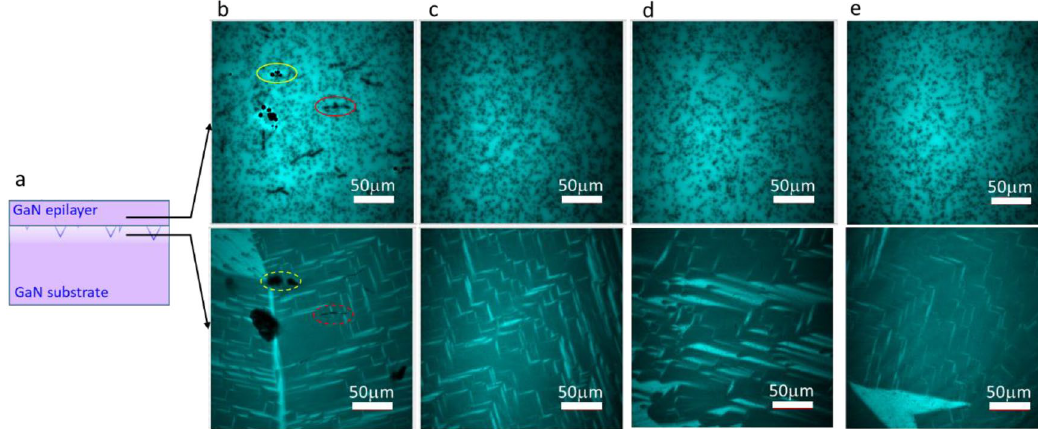
Figure 7. Multiphoton microscopy PL (365 nm) images of epitaxial layer (upper) and epitaxial layer/substrate interface (lower). ( a ) Cross-sectional schematic image showing the depth of observation. ( b ) Sample thinned by 18 µm. The red dashed circle indicates cracks, and the yellow dashed circle indicates holes on the substrate side immediately below the epitaxial layer/substrate interface. The generated dense dislocations (red circle) and voids (yellow circle) are observed in the epitaxial layer above the cracks and holes, respectively. The other dispersed black dots in the epitaxial layer are dislocations that originally existed in the substrate and propagated into the epitaxial layer. ( c ) Sample thinned by 47 µm. No dislocations are generated. ( d ) Sample thinned by 77 µm. No dislocations are generated. ( e ) Sample grown on commercially available epi-ready GaN substrate. No dislocations are